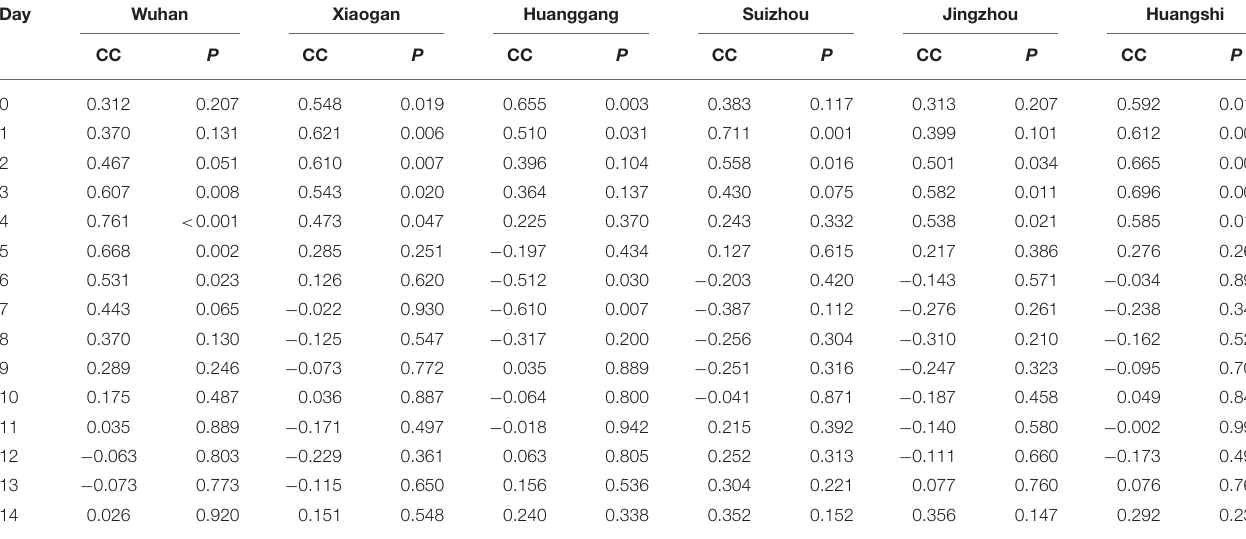
TABLE 1 | The correlations between the DNCC and daily maximum temperature 0–14 days prior to COVID-19 diagnoses in Hubei. Day